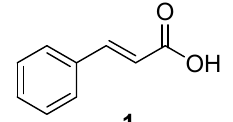
Figure 1. Chemical structure of cinnamic acid ( 1 ).